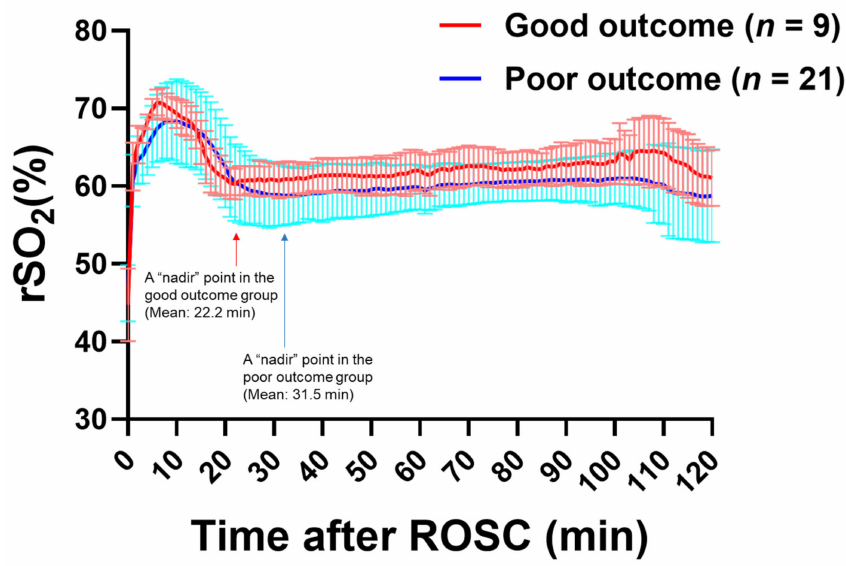
Figure 5. Serial change in regional cerebral oxygen saturation (rSO 2 ) during first 2 h after the return of spontaneous circulation (ROSC) in the good (a red line) and poor outcome (a blue line) groups. The 72-h survived rats were classified into binary groups using the NFS cut-off for good (NFS ≥ 60) and poor (NFS < 60) outcomes at 72 h post-ROSC. The rSO 2 value increased rapidly with ROSC and decreased to a “nadir” level after reaching the peak level. After reaching the nadir, the rSO 2 value increased gradually, showing a biphasic pattern. Fraction of inspired oxygen (F I O 2 ) was maintained at 1.0 after initiation of CPR. F I O 2 was gradually reduced to 0.6, 0.3, and 0.25 at 110, 115, and 120 min, respectively, followed by disconnection from mechanical ventilator and extubation. There were no significant differences in rSO 2 over time between the good and poor neurological outcome groups; p = 0.92 for the two-way analysis of variance. The red and blue arrows indicate the “nadir” of rSO 2 in the good and poor outcome groups, respectively. Data are presented as mean ± SD.